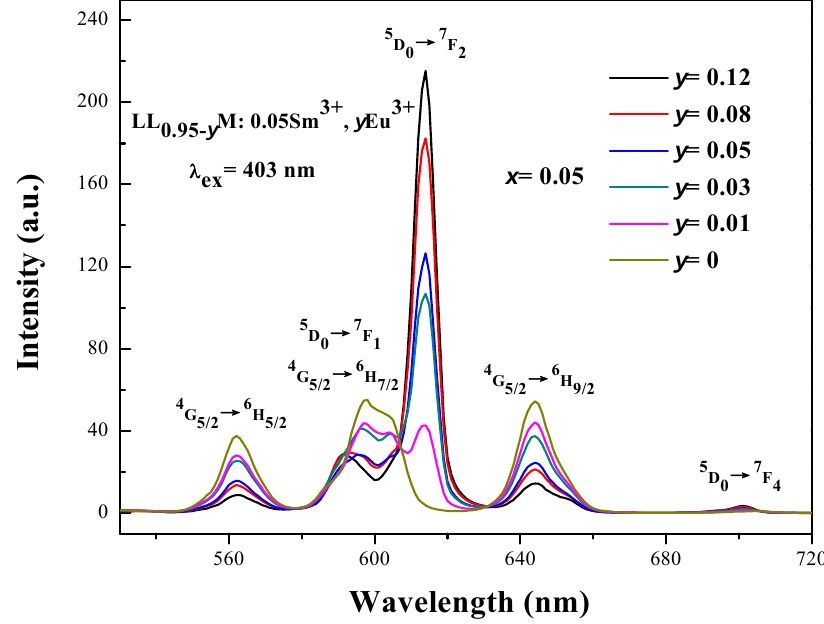
Figure 6. The PL (photoluminescence emission) spectrum of LL 0.95 − y M:0.05Sm 3+ , y Eu 3+ ( y = 0, 0.01, 0.03, 0.05, 0.08, 0.12) under the excitation of 403 nm.